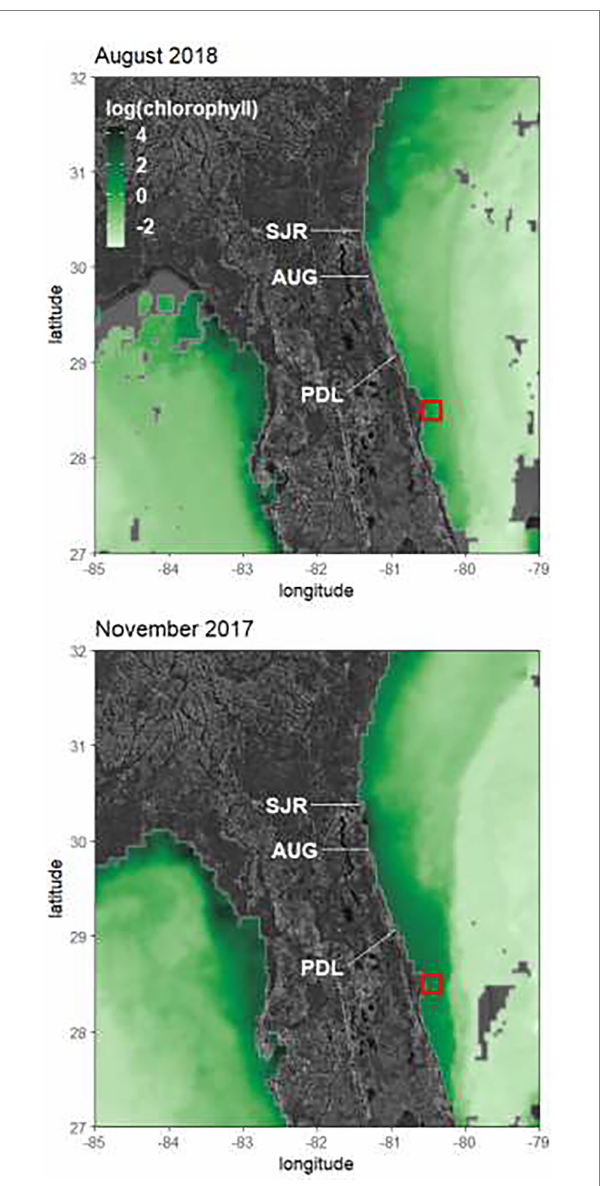
FIGURE 13 Pairwise correlation between physical/chemical variables and chlorophyll concentration during sampling period. Scale is in Pearson’s correlation